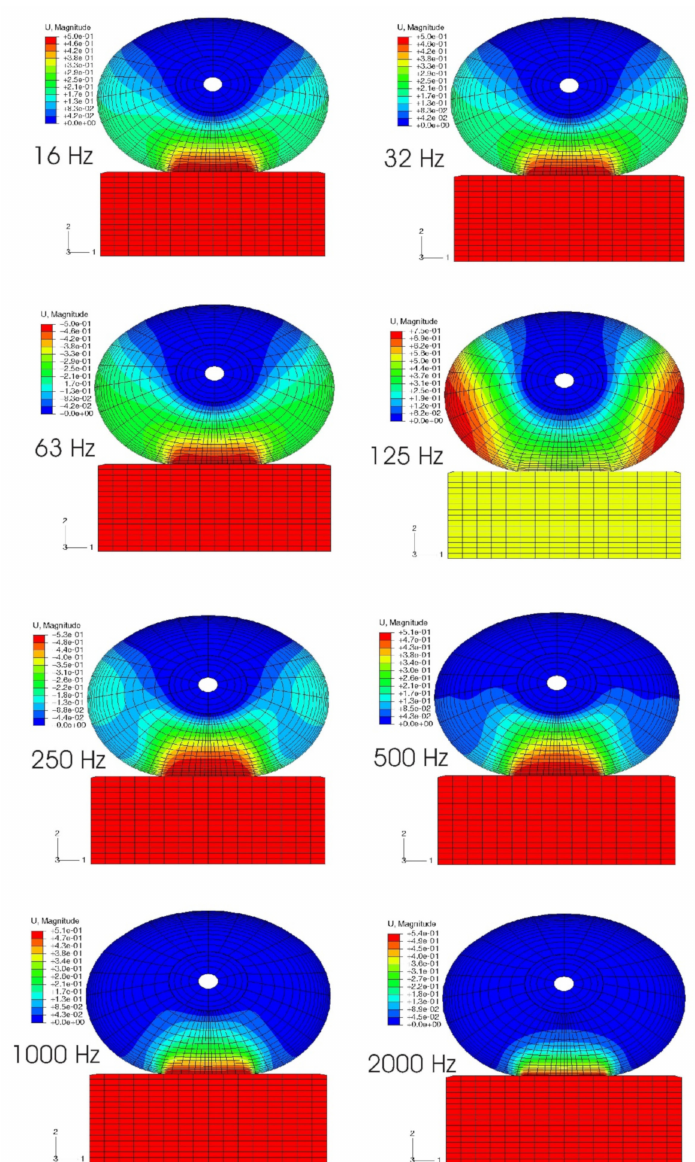
Figure 10. The model predictions of the distributions of vibration magnitude (U, Magnitude, mm) for eight different vibration frequencies (f = 16, 32, 63, 125, 250, 500, 1000, and 2000 Hz) [127]. The fingertip is pre-compressed by 1 mm before being subjected to harmonic